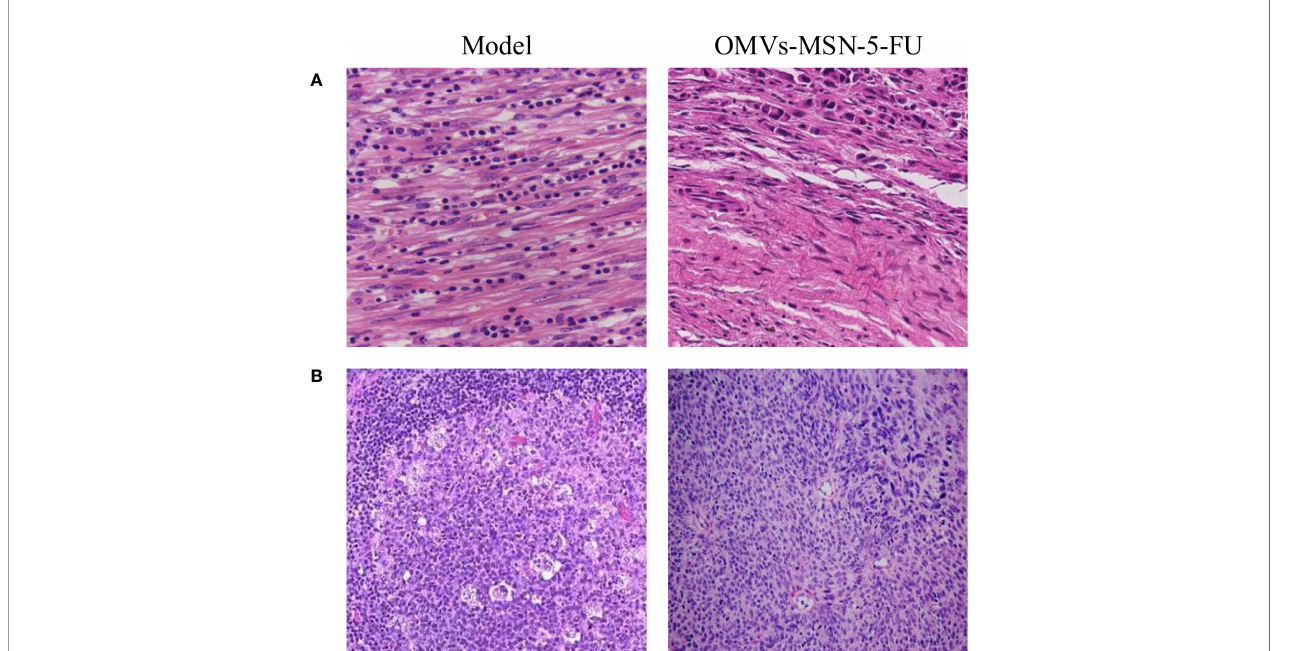
FIGURE 10 | HE staining of tissue sections after treatment. (A) was HE staining of tissue sections adjacent to the carcinoma (×400); (B) was HE staining of the tissue sections of cervical lymph node metastases